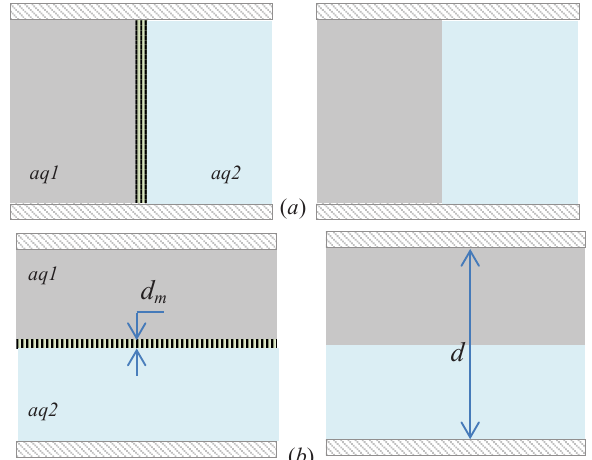
Fig.1: Models for field distribution with and without membranes: (a) The case where the electric field is perpendicular to the membrane; (b) The case where the electric field is parallel to the membrane.